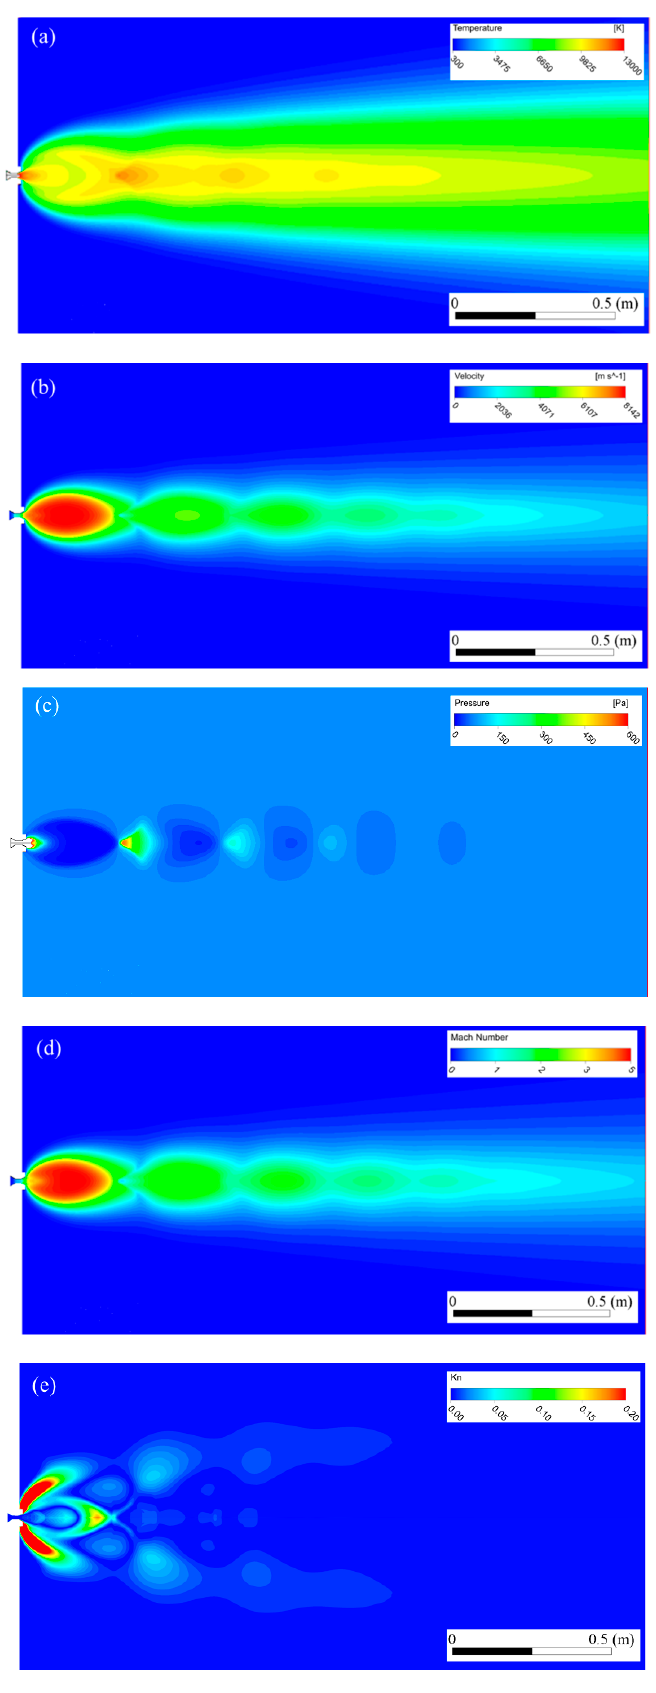
Figure 6. 60Ar–30He plasma jet fields at 60 kW and 100 Pa: ( a ) temperature, ( b ) velocity, ( c ) pressure, ( d ) Mach number, and ( e ) Knudsen number.